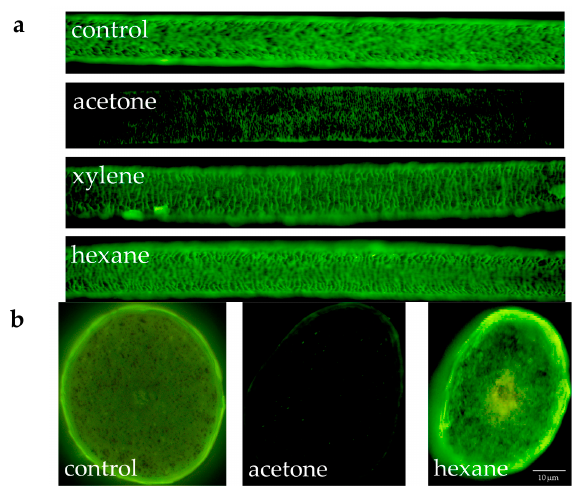
Figure 3. Fluorescence microscope images of fluorescence due to hydroxy radicals in the cross-section of defatted human hair not exposed or exposed to UV radiation. ( a ) Images of the surface of hair when human hair was defatted with acetone, xylene or hexane and exposed to UV radiation; ( b ) Images of the cross-section of hair when human hair was defatted with acetone or hexane and exposed to UV radiation. PBS was used as a control instead of the organic solvents used for defatting.